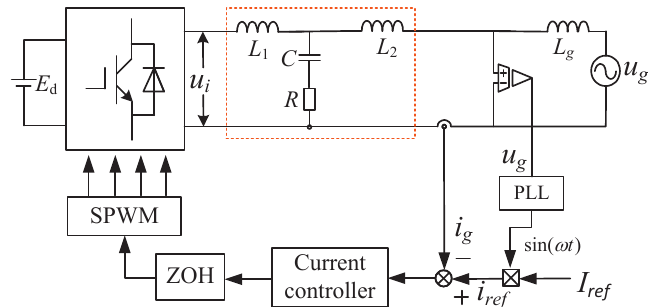
Figure 5. LCL-type single-phase grid-connected inverter model.